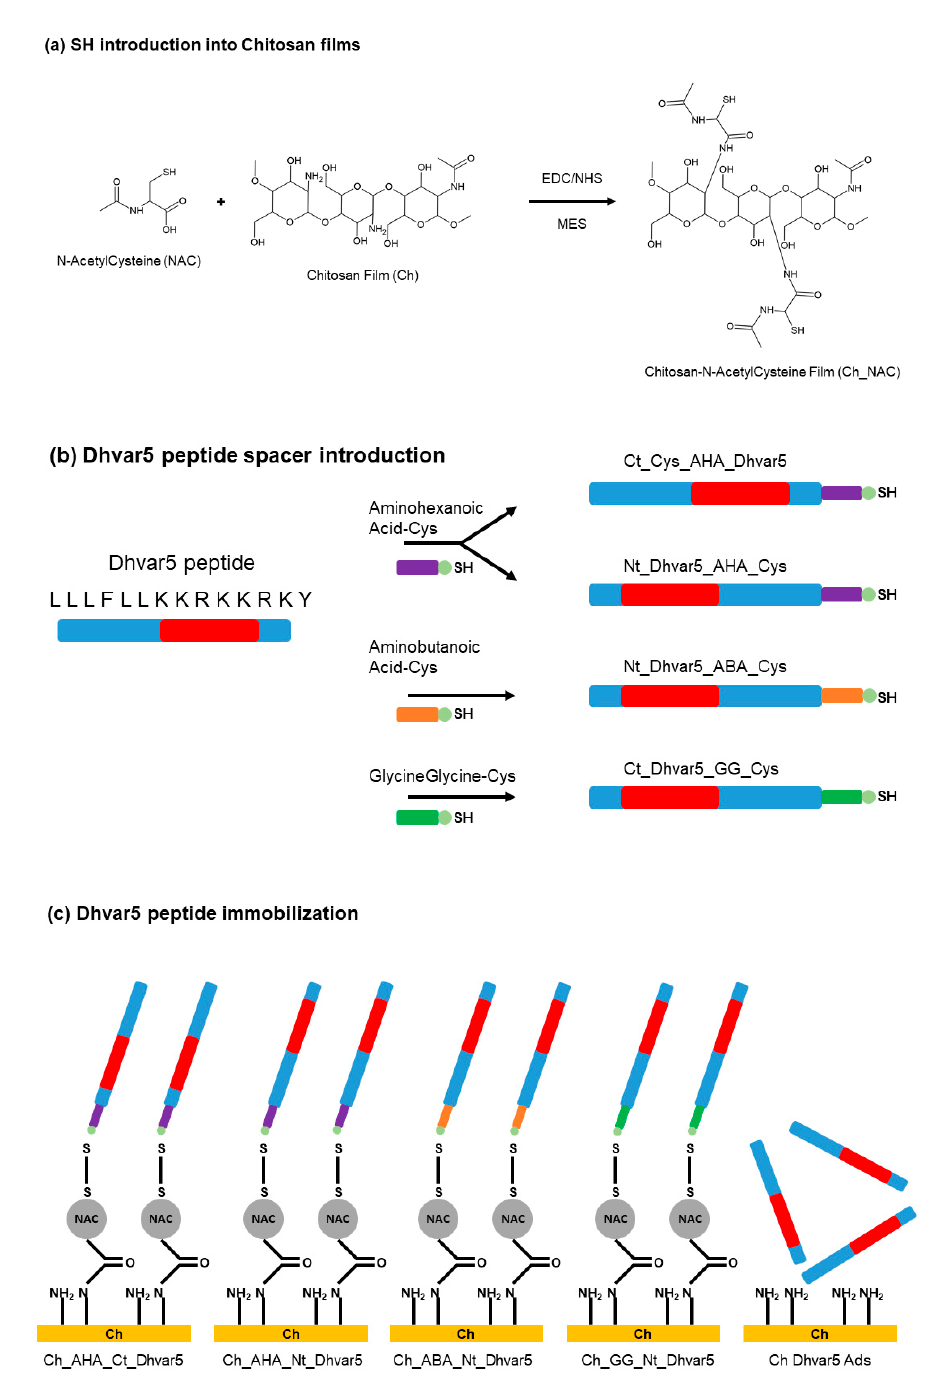
Figure 21. ( a ) Chitosan modification with N-acetyl cysteine (NAC); ( b ) Dhvar5 peptide derived in Table 2 peptides by disulfide bridge formation (a control surface, Ch Dhvar5 ads, was used where peptide was only physisorbed, not covalently bound). ( c ) Dhvar5 peptide immobilization strategy. Reproduced from [98]. Copyright © 2015 Elsevier Ltd. All rights reserved.